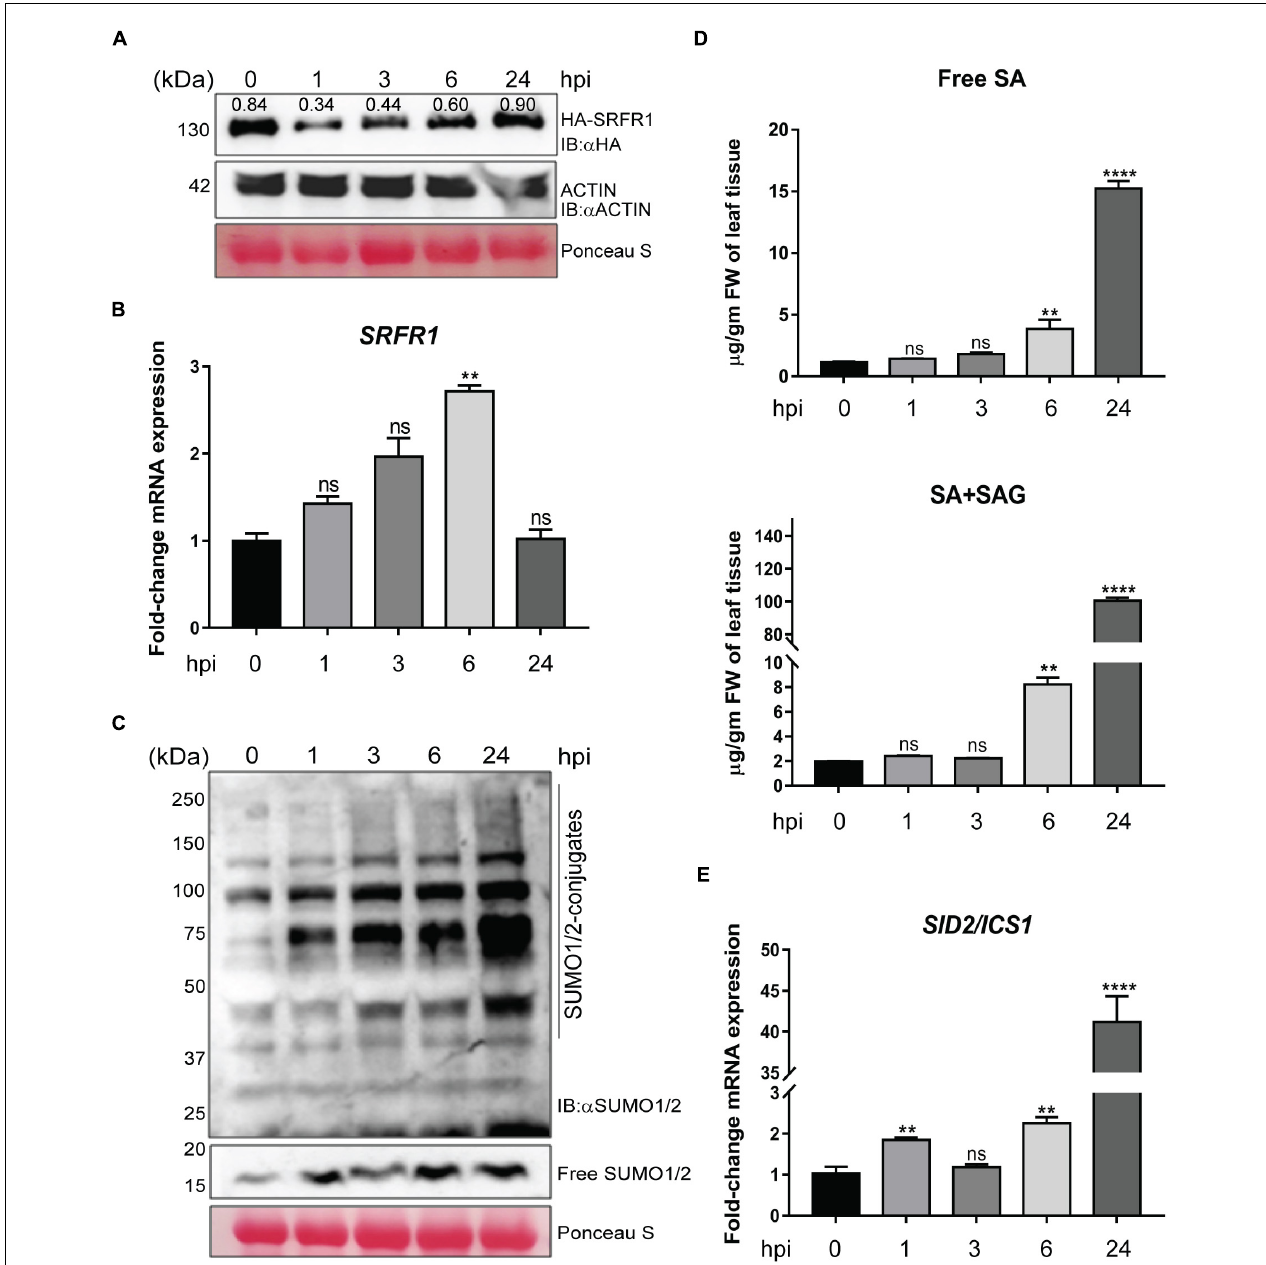
FIGURE 1 | SRFR1 protein instability promotes salicylic acid (SA) and SUMOylome elevations in basal defenses. At progressive time points (hpi, hours post-infection) upon PstDC3000 challenge (A) immunoblot of HA-SRFR1, (B) expression levels of SRFR1 transcripts, (C) SUMO1/2-conjugates and free SUMO1/2 levels, (D) free SA and total SA + SAG levels, and (E) expression of SID2/ICS1 . Blots were probed with anti-HA or anti-SUMO1/2 antibodies, as indicated. Ponceau S-stained membrane or anti-actin immunoblot shows comparable protein loading across samples. Numbers above the HA-SRFR1 protein bands in panel (A) are densitometric quantification values relative to actin expression levels in the same extracts. Transcript abundance is relative to internal control MON1 gene expressions and presented as fold-change relative to uninfected (0 hpi) samples ( n = 3). Statistical significance is by pairwise comparison with 0-hpi sample with Student’s t -test (** p < 0.01, **** p < 0.0001, and ns = not significant).